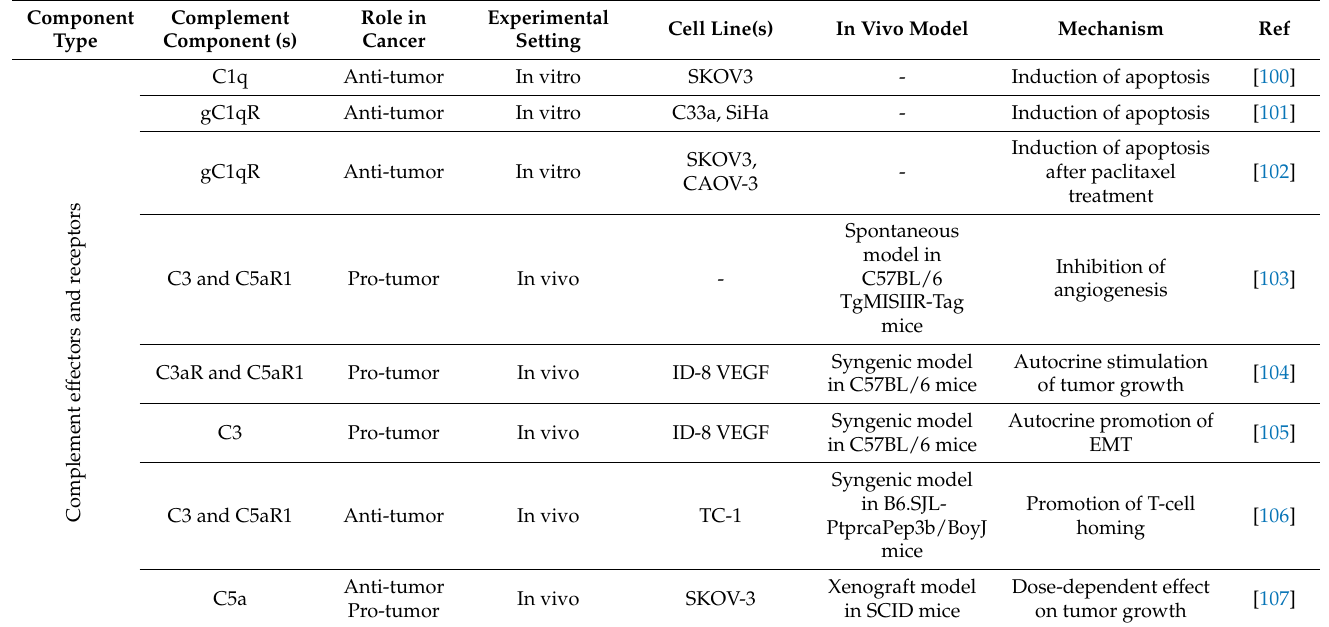
Table 1. Summary of the studies in ovarian cancer cell lines and mouse models reporting tumor-promoting or tumor- suppressing activities mediated by complement